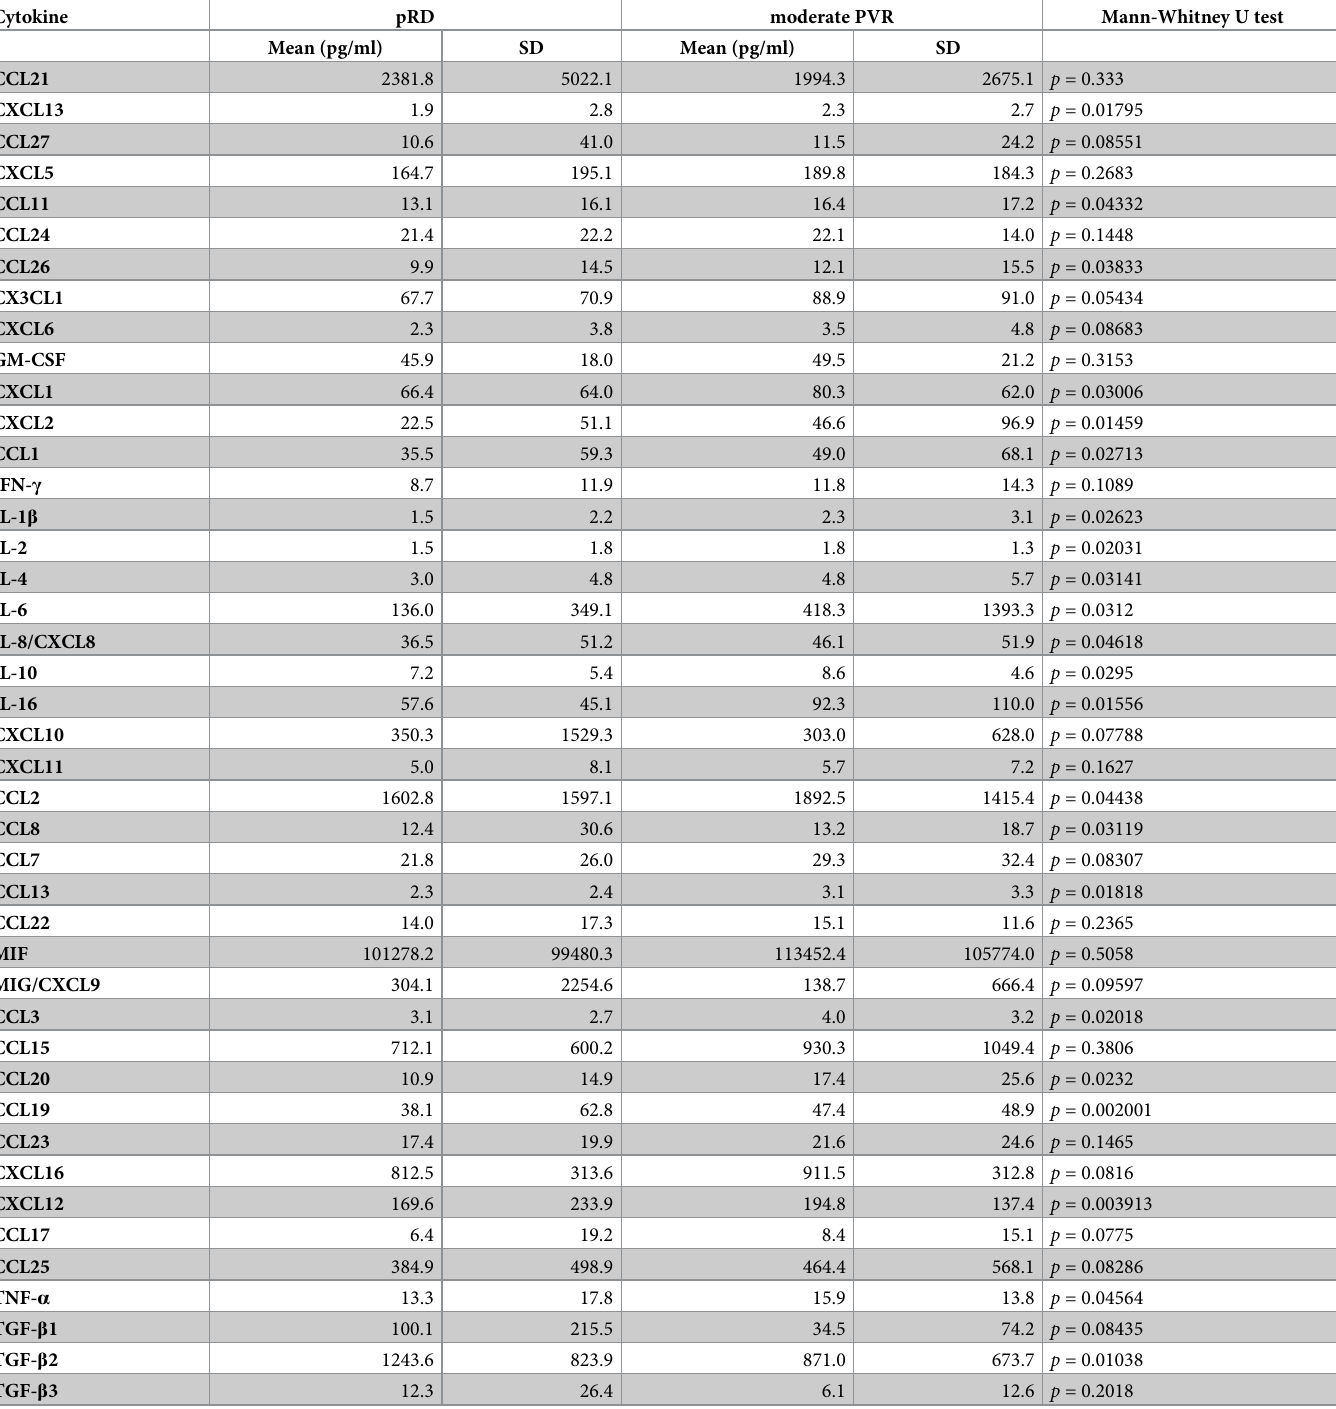
Table 1. Mean concentrations (pg/ml) and standard deviations (SD) of cytokines in the vitreous of eyes with primary retinal detachment without PVR (pRD) and in eyes with primary retinal detachment with moderate PVR treated with SF 6 gas tamponade. Cytokine pRD moderate PVR Mann-Whitney U